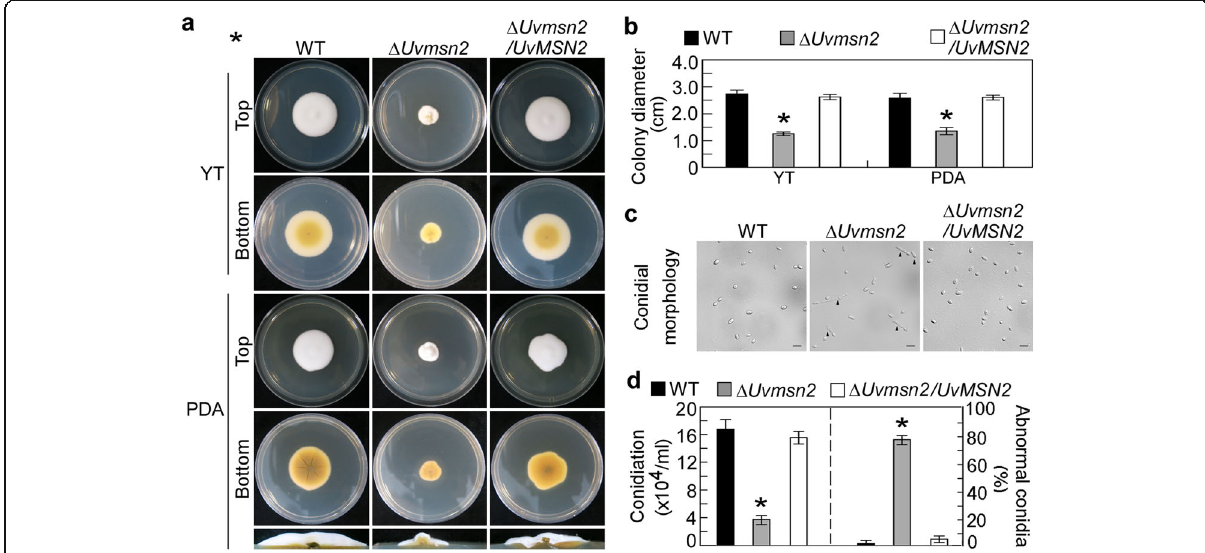
Fig. 2 UvMsn2 is important for vegetative growth and conidiogenesis in Ustilaginoidea virens . a Vegetative growth and colony morphology of the wild-type HWD-2, Δ Uvmsn2 mutant and the complemented transformant Δ Uvmsn2 / UvMSN2 cultured on YT and PDA agar plates, and photographed at 14 dpi at 25 °C in the dark. b Statistical analysis of the colony diameter of the indicated strains. The mean values ± SD were calculated from three independent experiments, and asterisks indicate a statistically significant difference from the wild-type strain ( P < 0.01). c Conidial morphology of the indicated strains. Black triangles indicate abnormal conidia. Bar = 10 μ m. d Conidial production of the indicated strains. The mean values ± SD were calculated from three independent experiments, and asterisks indicate a statistically significant difference from the wild-type strain ( P <